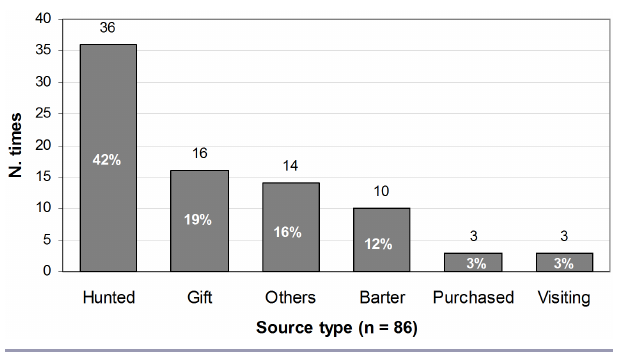
Fig. 2 . Source type of bushmeat consumed by individual.